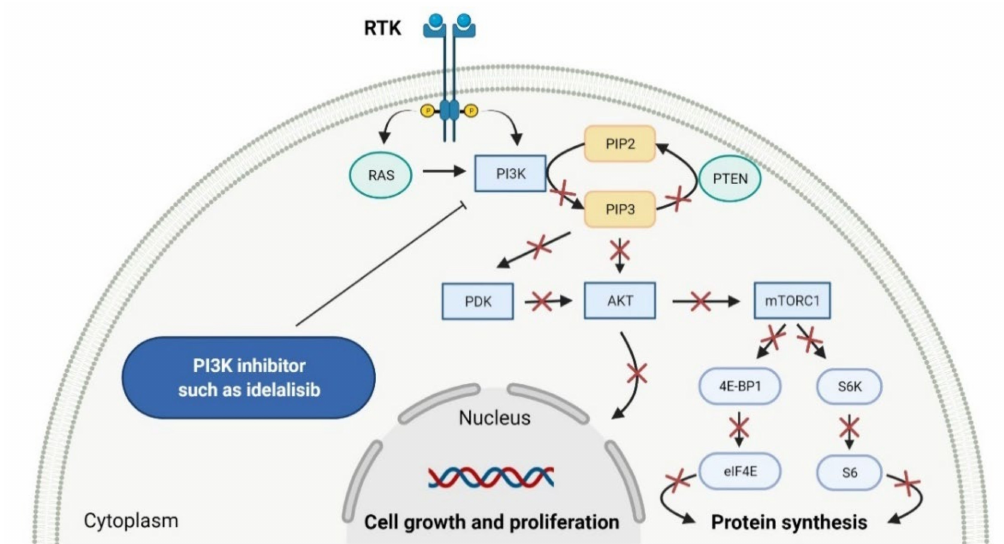
Figure 3. Mechanism of action of PI3K inhibitors. RTK : receptor tyrosine kinase. PI3K : phos- phatidylinositol 3-kinase. PIP2 : phosphatidylinositol 4,5-bisphosphate. PIP3 : phosphatidylinositol- 3,4,5-trisphosphate. PTEN : phosphatase and tensin homolog deleted on chromosome ten. PDK : 3-phosphoinositide-dependent protein kinase. AKT : protein kinase B. mTORC1: mammalian target of rapamycin complex 1. 4E-BP1 : 4E-binding protein 1. eIF4E : eukaryotic translation initiation factor 4E. S6K : p70S6 kinase. S6 : S6 protein. Created with BioRender.com based on information in